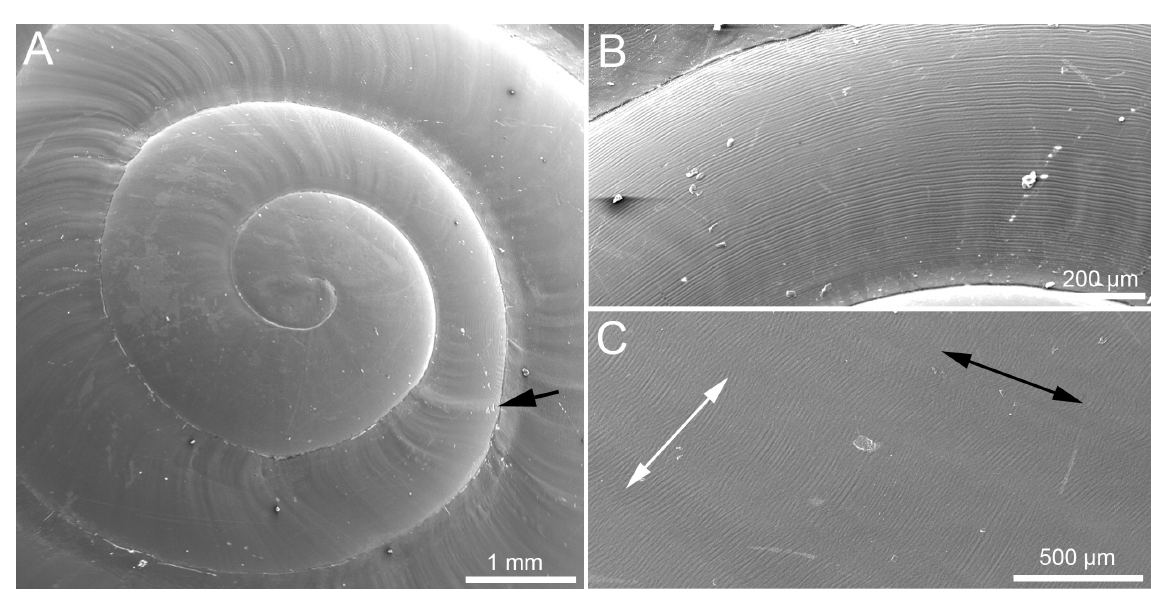
Fig. 4. Shell sculpture of a paratype (BNHS GAS 119) of Varadia amboliensis Bhosale, Thackeray, Muley & Raheem gen. et sp. nov. A . Protoconch showing irregular collabral lines; black arrow indicates the approximate point of transition from the protoconch to the teleoconch. B–C . Close longitudinal striae of protoconch (B) and teleoconch (C). The direction of the longitudinal striae and the faint collabral striae (barely evident) are shown, respectively, by the white and black arrows in C.